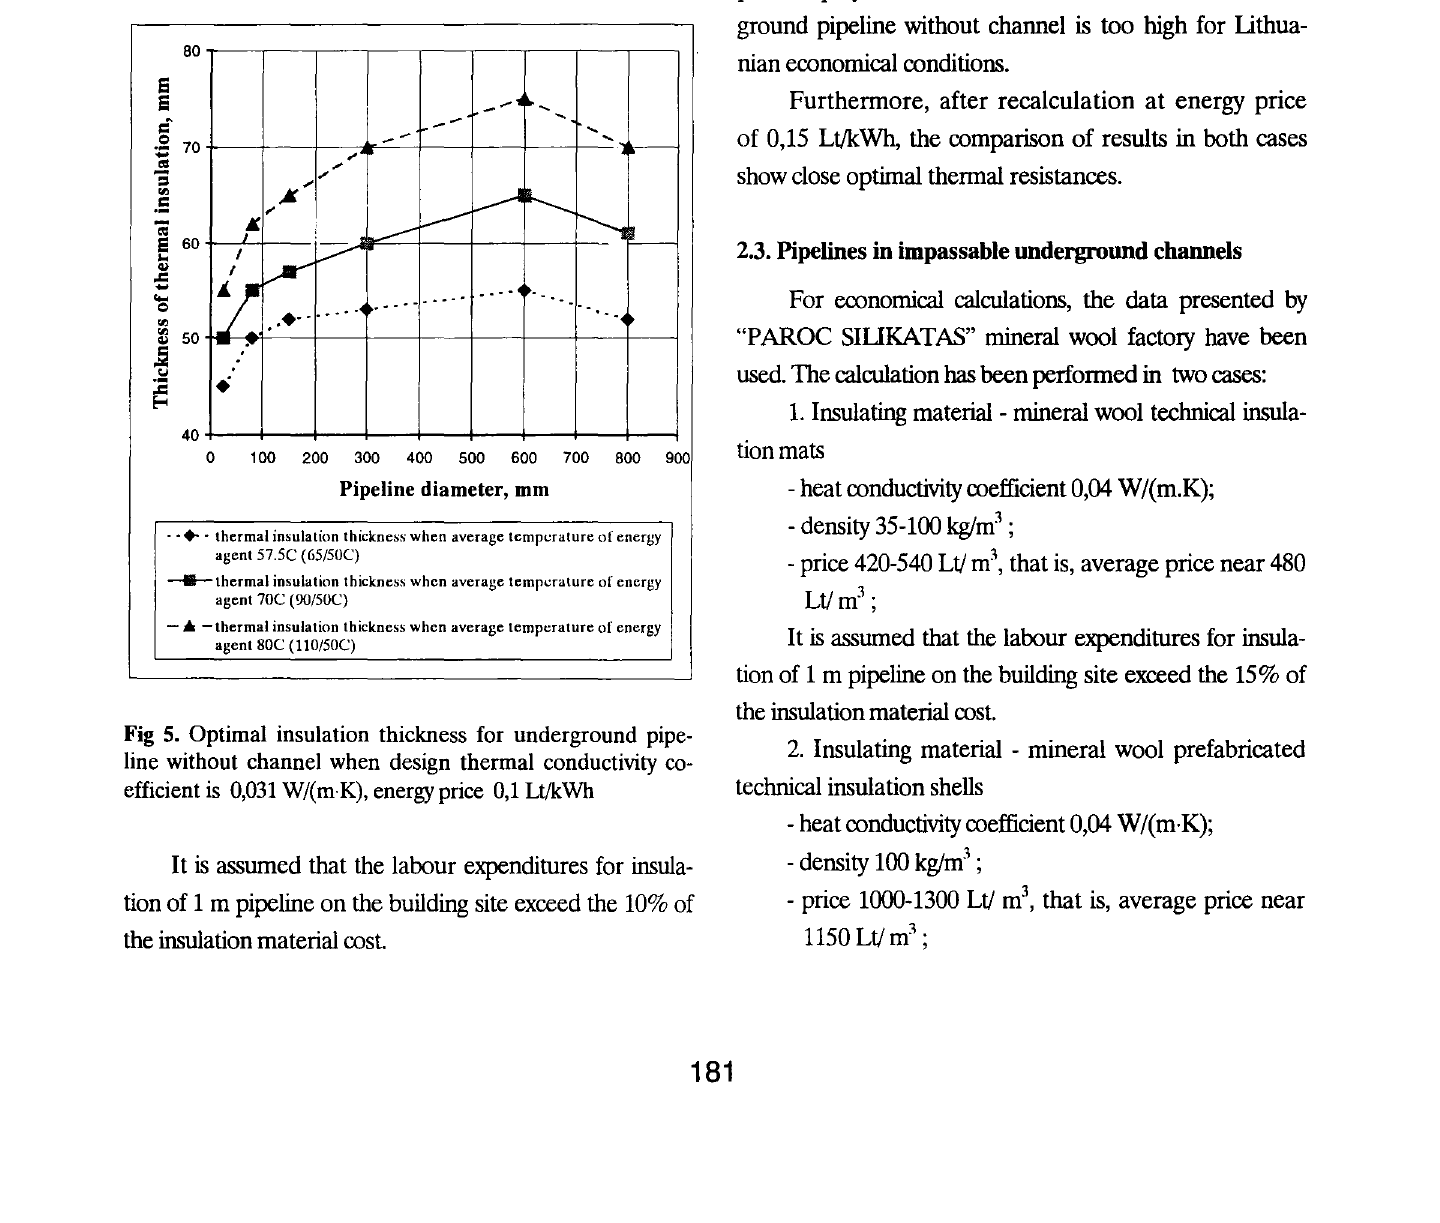
Fig 4. Optimal thickness of open space pipeline insulation when design thermal conductivity coefficient is 0,04 W/(m-K), energy price 0,1 Lt/k:Wh